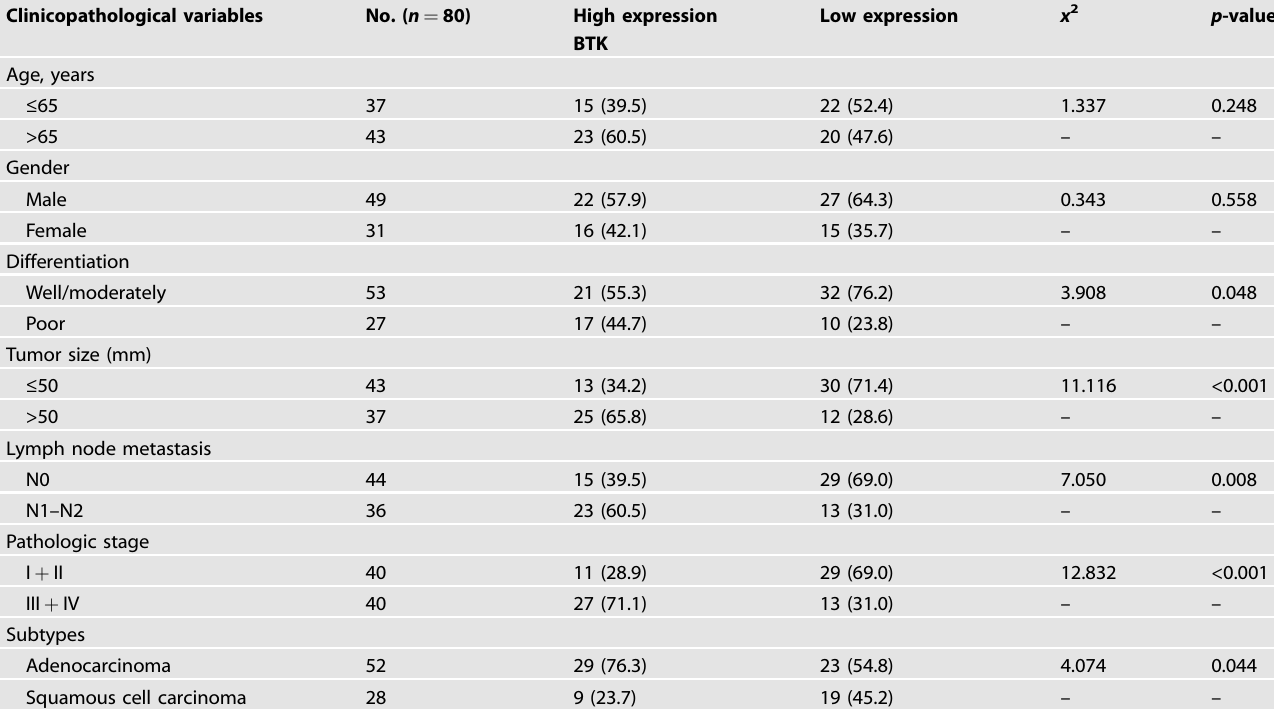
Table 1. Patient clinicopathological characteristics of the NSCLC